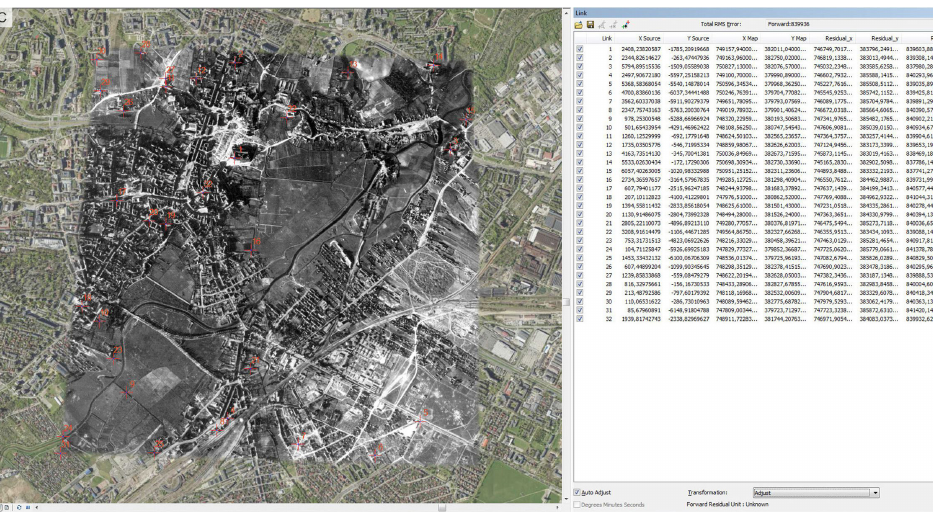
Fig. 8. Georeferencing of an aerial photograph from 1944 Lublin – Stare Miasto, Bronowice, Tatary . A – first-degree polynomial transformation (without changing the geometry of the photo, the resulting image has the largest local mismatch of control points); B – perspective transformation (trapezoidal distortion, preserving the internal proportions of the photo and the pixel sequence, moderate local mismatch of control points); C – folding transformation (TPS/adjust – segmentation of the raster matrix and linear interpolation of pixels in a variable-density triangular network, absolute matching of control